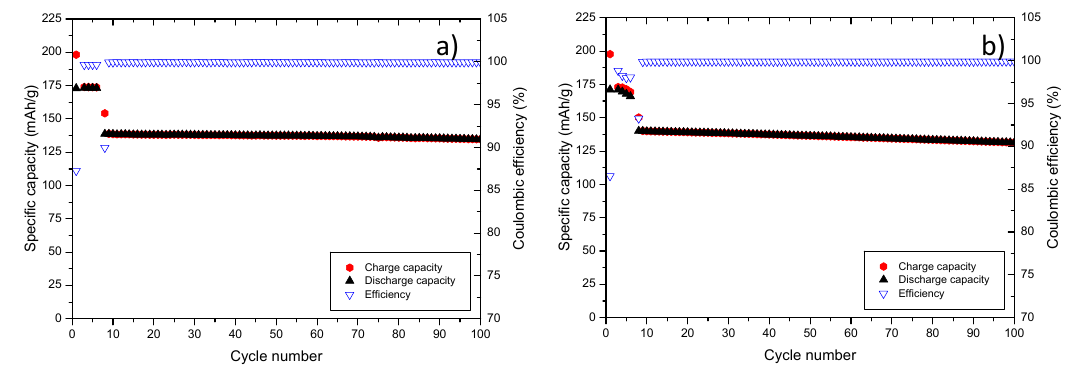
Figure 11. Cycling profiles of NMC/graphite cells containing ( a ) 1 M LiPF 6 in EtiPrSO 2 :EA (1:1) + 4% FEC and ( b ) 1 M LiPF 6 in MeiPrSO 2 :EA (1:1) + 4% FEC, in the voltage range from 3.0 to 4.3 V.